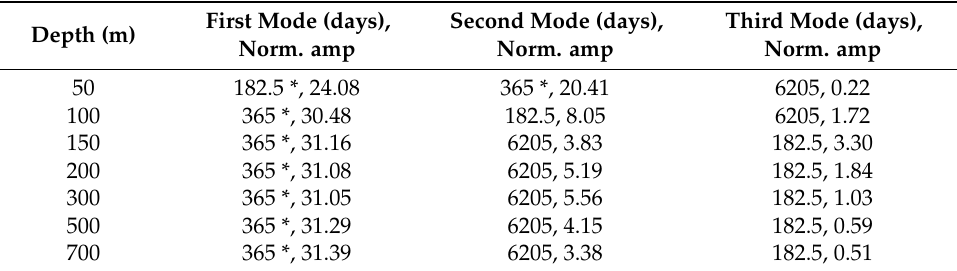
Table 2. First three modes (days) of the spectral analysis and their normalized amplitudes of the OHC of the surface to 50 m, 100 m, 150 m, 200 m, 300 m, 500 m, and 700 m depths. Values marked with an asterisk (*) are significant at a 99% confidence